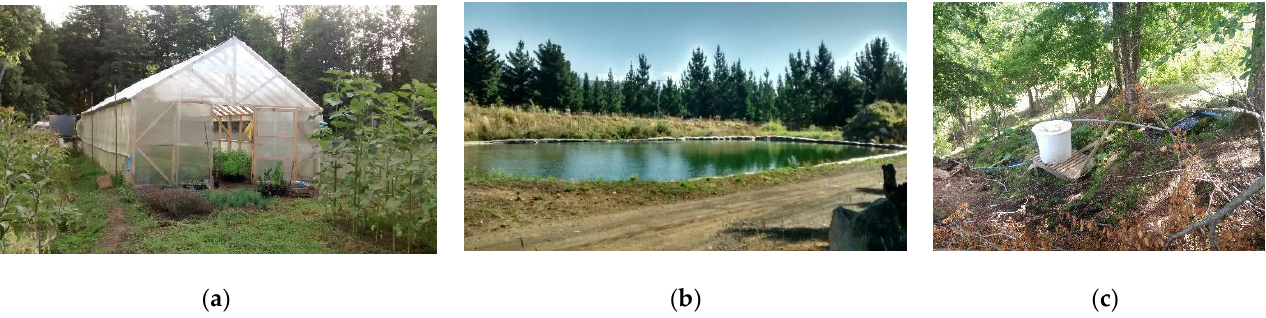
Figure 5. Various forms of rainwater harvesting: in a greenhouse ( a ), rainwater harvesting in a micro-reservoir ( b ), and the use of slopes and shadows ( c ). Source: authors.